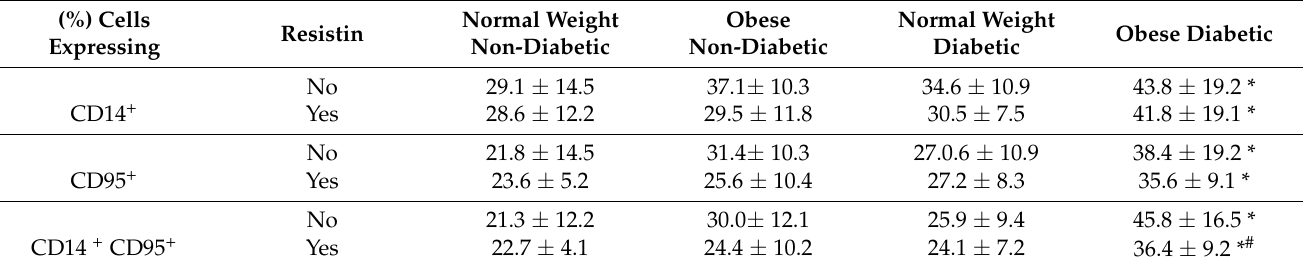
Table 2. Percentage of CD14 + cells treated with resistin or untreated, expressing Fas (CD95) in mothers with different glycemic and nutritional